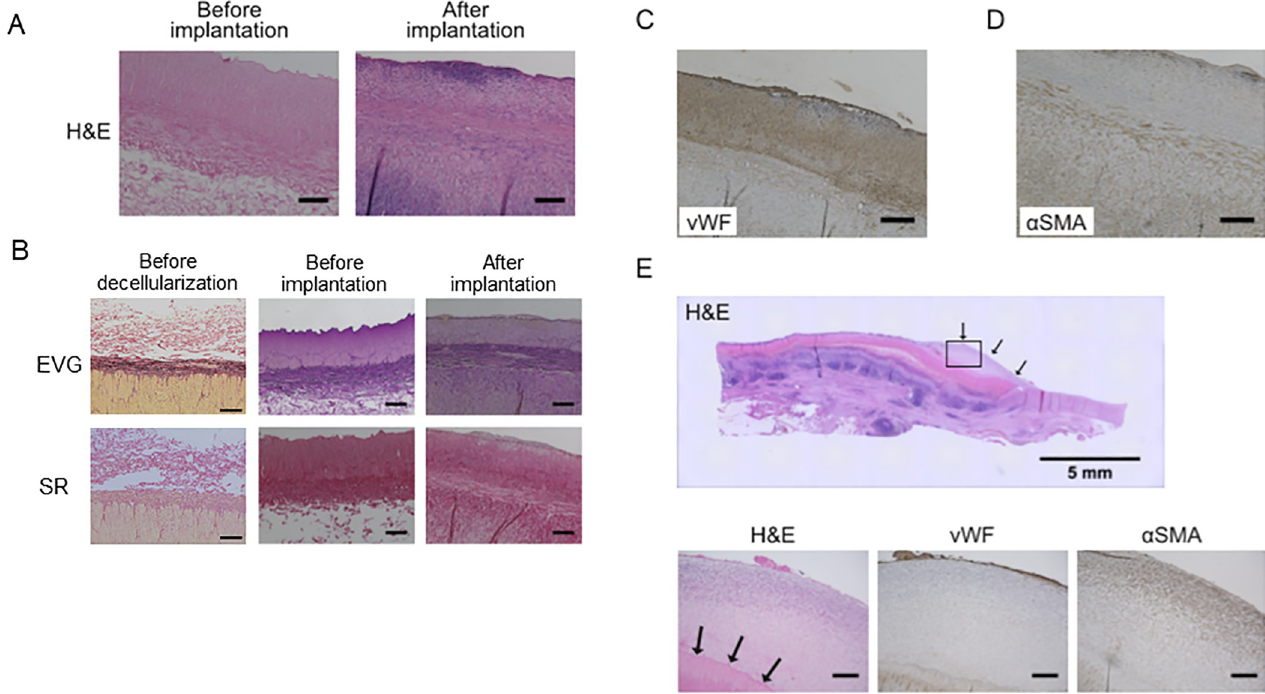
Fig 4. Histological evaluations for decellularized grafts after implantation. (A) Representative Hematoxylin and Eosin (H&E) staining before implantation (left) and 4 weeks after implantation (right). Scale bars = 200 μ m. ( B ) Representative Elastica van Gieson (EVG) staining and Sirius red (SR) staining, before implantation (left) and 4 weeks after implantation (right). Scale bars = 200 μ m. ( C ) Representative von Willebrand Factor (vWF) immunostaining at 4 weeks after implantation. Scale bar = 200 μ m. ( D ) Representative α -smooth muscle actin staining at 4 weeks after implantation. Scale bar = 200 μ m. € H&E staining for representative stenotic regions close to proximal anastomoses at 4 weeks after implantation. Black arrows indicate hypertrophic region (top). H&E staining (bottom left), vWF immunostaining (bottom middle), and α -smooth muscle actin ( α SMA) immunostaining (bottom right) for hypertrophic region indicated with square in top figure. Scale bars = 200 μ